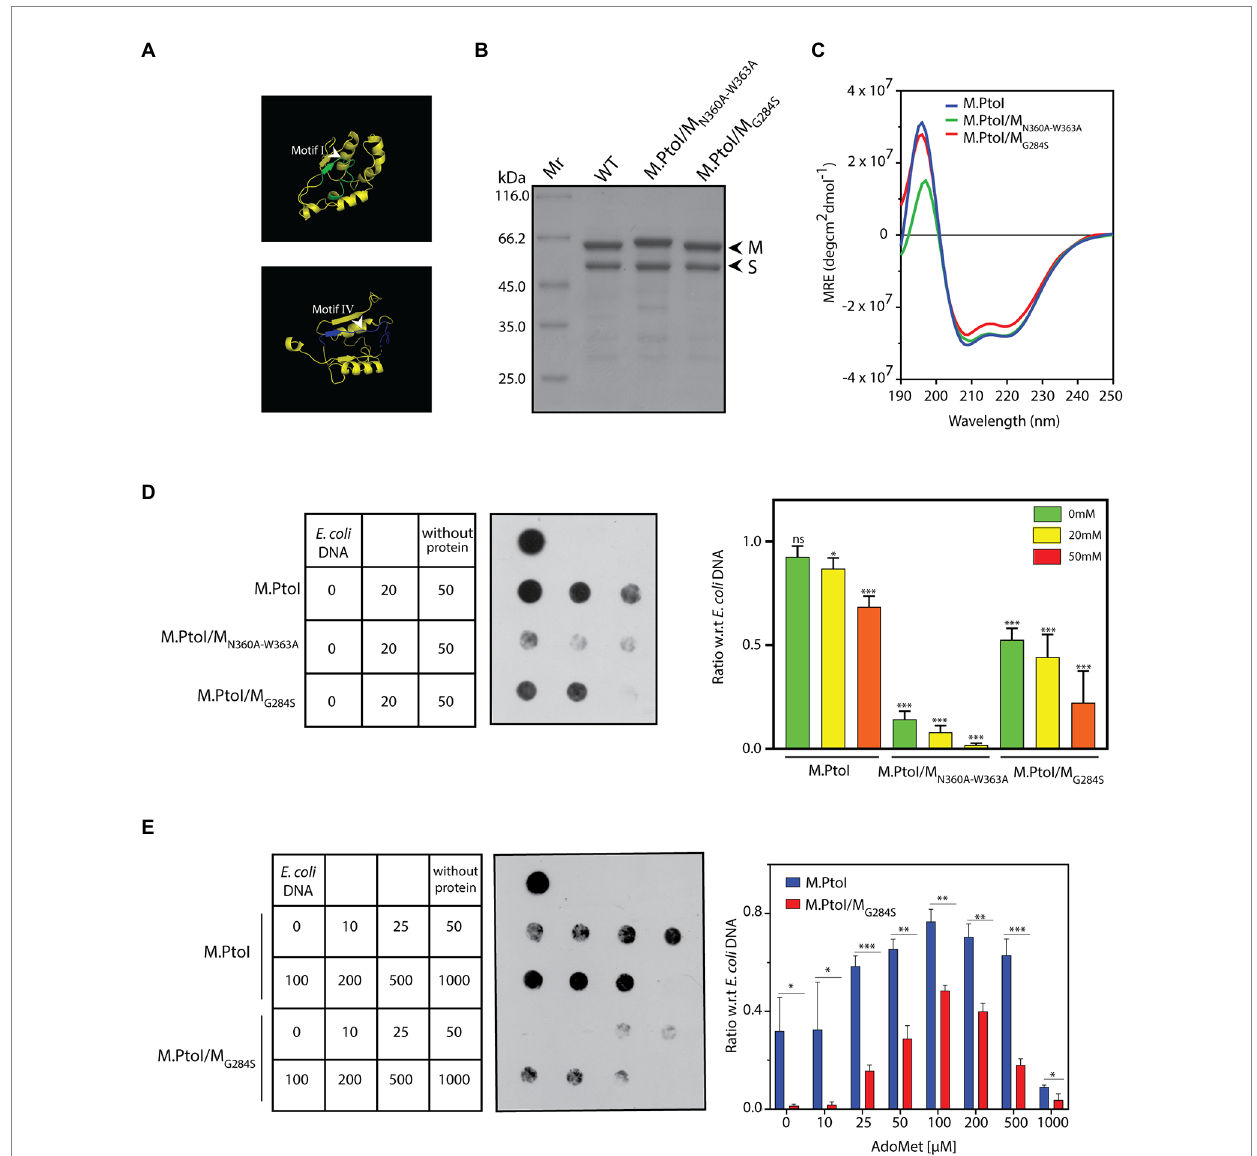
FIGURE 8 (A) Ribbon representation of motif I and motif IV derived from the predicted structure of M subunit of M.PtoI. (B) Coomassie stained SDS-PAGE analysis of purified recombinant M.PtoI/M N360A-W363A and M.PtoI/M G284S. Mr.: molecular weight marker. Arrowheads depict M and S subunits (63 kDa and 48 kDa respectively). (C) CD spectra of M.PtoI/M N360A-W363A and M.PtoI/M G284S depicted as a measure of mean residue ellipticity (MRE). (D,E) Dot blot analyses of methylation assays with mutant M.PtoI proteins. Assays were performed as described in the legend to Figure 7 unless otherwise specified. Left panel: loading scheme of dot blot. Middle panel: Dot blot of assay. Right panel: quantification of signals from methylation reactions as a ratio of E.coli genomic DNA signal, done using ImageJ software. Data represent average of three experiments. Error bars represent standard deviation. Student’s two-tailed t- test was applied, * p < 0.05, ** p < 0.005, *** p < 0.0005, ns-not significant. (D) Reactions with M.PtoI, M.PtoI/M N360A-W363A and M.PtoI/M G284S . Activity assayed as a function of sodium chloride concentration (0–50 mM) at pH 5. Numbers in boxes represent NaCl concentrations (mM). Reaction without protein had 20 mM NaCl. (E) Reactions with M.PtoI and M.PtoI/M G284S . Activity assayed as a function of AdoMet concentration (0–1,000 μ M). Numbers in boxes represent AdoMet concentrations ( μ M). Reaction without protein had 100 μ M